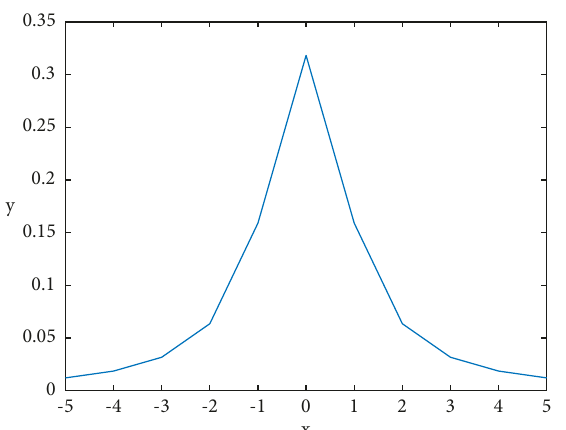
Figure 1: Standard Cauchy distribution probability density function curve.